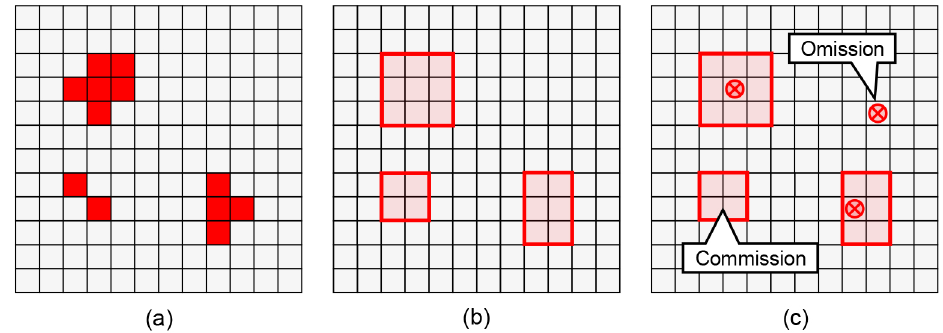
Figure 5. Schematics showing ( a ) the wilted pine tree pixels masked by the threshold α , ( b ) the candidate bounding boxes ( BB s) converted from the pixel-based result, and ( c ) the omission and commission errors defined based on the locations of wilted pine trees and BB